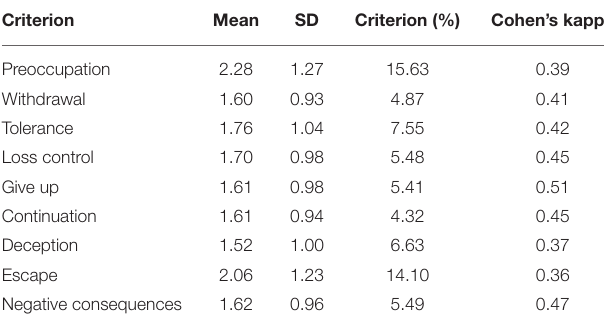
TABLE 3 | Endorsement of DSM-5 IGD criteria ( n =